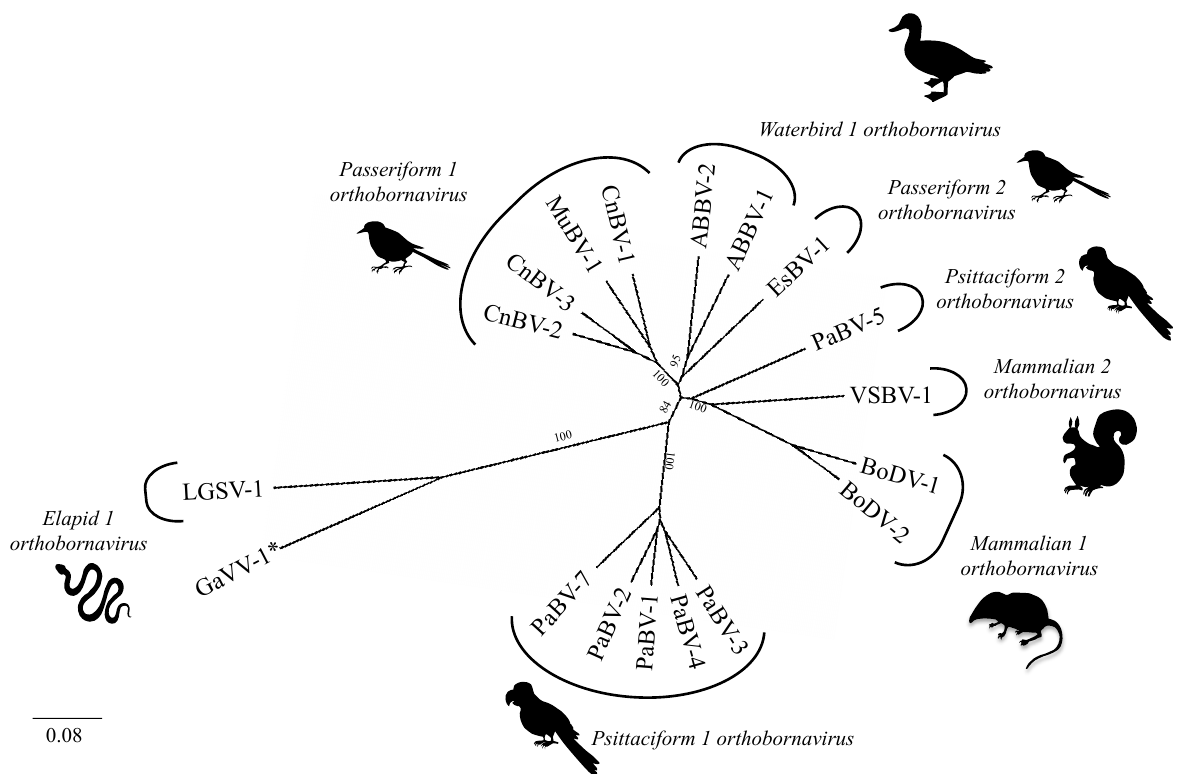
Figure 1. Phylogeny of the genus Orthobornavirus . Complete P gene sequences (606 nucleotides) of representative or- thobornavirus sequences were analyzed using the neighbor-joining algorithm and the Jukes–Cantor distance model in the Geneious R11 software. Values at branches represent support in 1000 bootstrap replicates. Only boot-strap values ≥ 70 at major branches are shown. * These viruses have yet not been classified by the International Committee on Taxonomy of Viruses (ICTV). ABBV: aquatic bird bornavirus; BoDV: Borna disease virus; CnBV: canary bornavirus; EsBV: estrildid finch bornavirus; GaVV: Gabon viper virus; LGSV: Loveridge’s garter snake virus; MuBV: munia bornavirus; PaBV: parrot bornavirus; VSBV: variegated squirrel